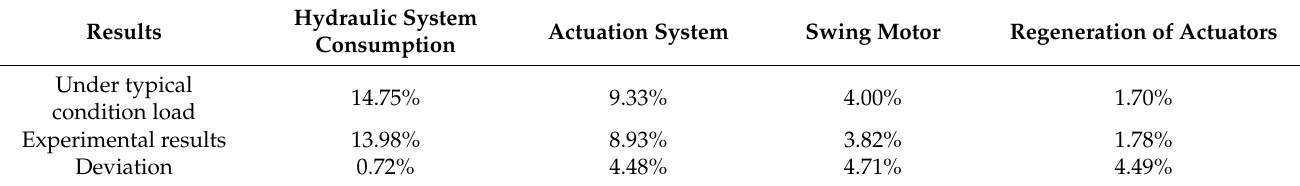
Table 6. Operation system energy flow results comparison under operation conditions.